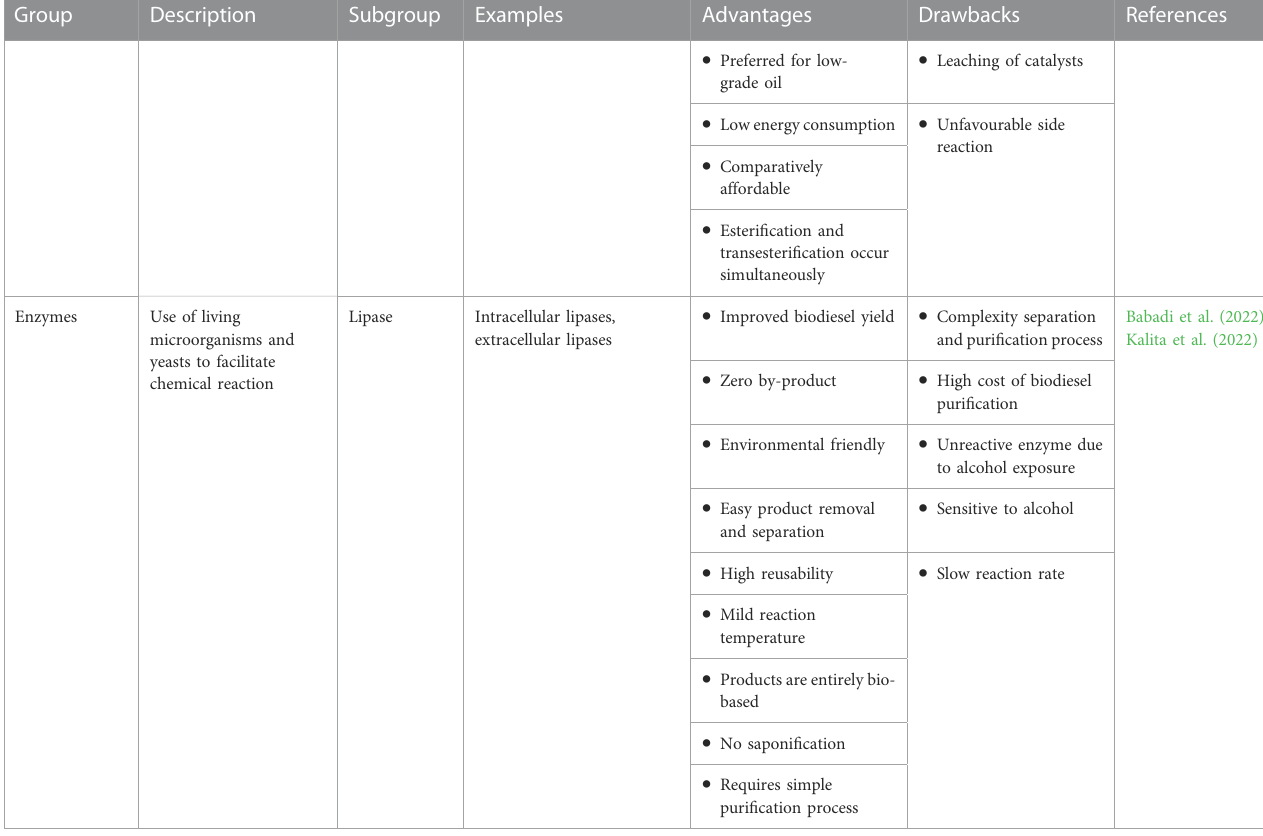
TABLE 2 ( Continued ) Examples, advantages, and drawbacks of classes of catalysts for biodiesel production.